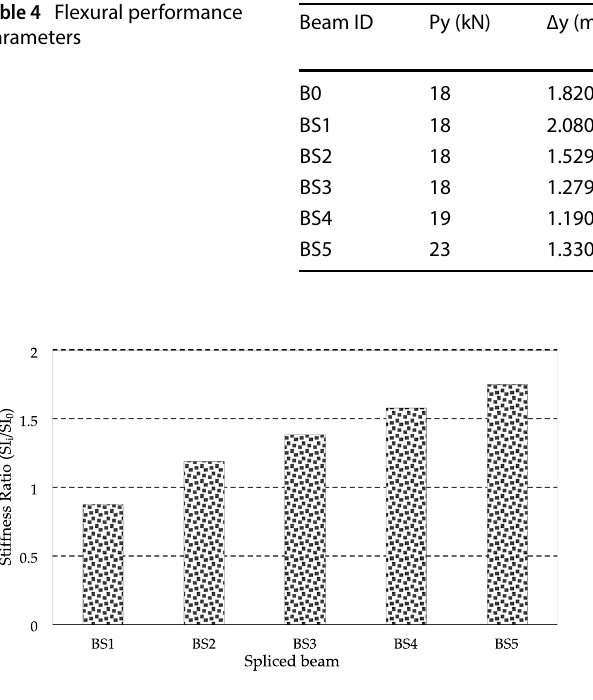
Fig. 5 Influence of splice length on beam